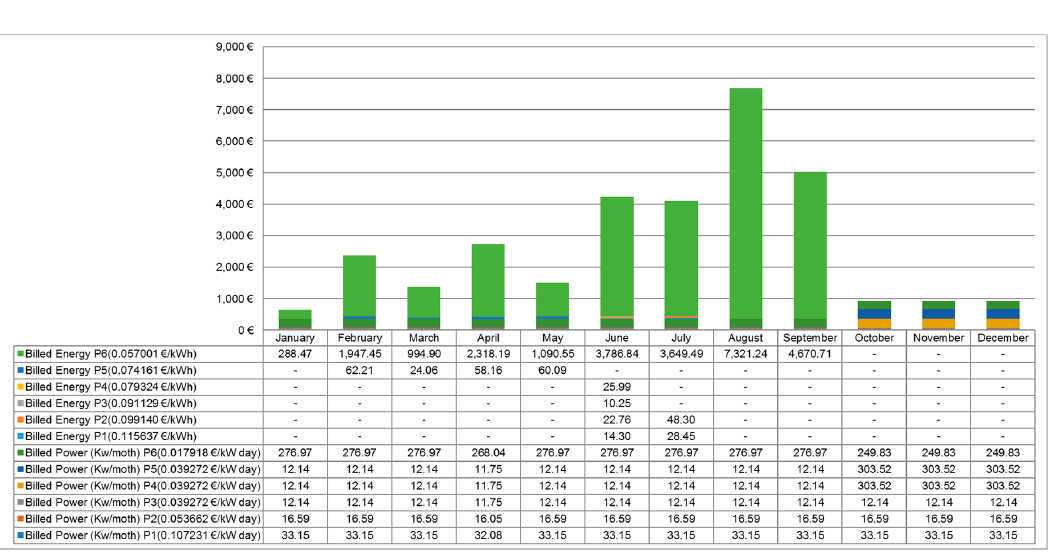
Figure 5. TST Financial expense. 2016.